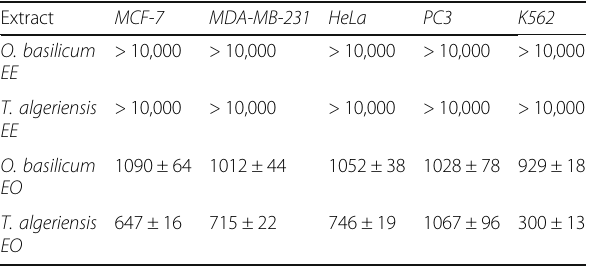
Table 6 Antiproliferative activities of O. basilicum and T. algeriensis ethanolic extracts and essential oils on five human cancer cell lines, exposure time 48 h. LD 50 ( μ g/mL) values are shown ±SD